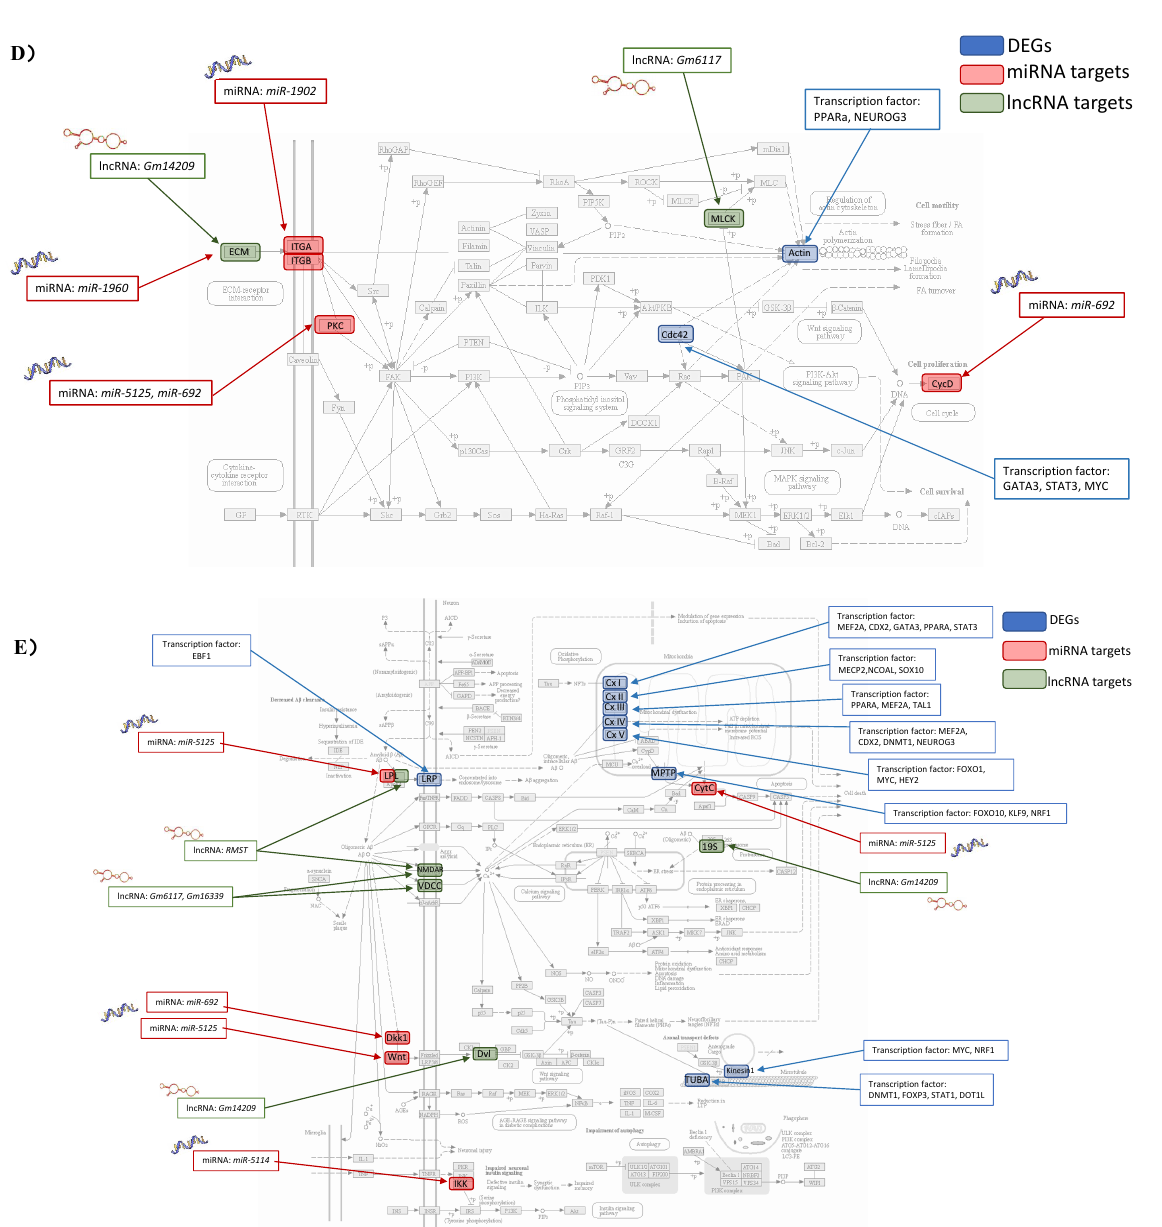
Figure 4. Effect of the high glycemic diet (HGD) on cellular pathways of differentially expressed protein-coding genes, miRNA targets, and LncRNA targets in the hippocampal microvasculature. ( A ) Network of differentially expressed protein-coding genes (grey circles), transcription factors (red hexagons), miRNAs (green diamonds) and their targets (blue circles), LncRNAs (purple rectangles) and their targets (blue circles) in the hippocampal microvessels for the high glycemic diet (HGD) compared to the low glycemic diet (LGD). ( B ) Histogram of a subset of the relevant pathways of differentially expressed protein-coding genes, miRNA targets, and LncRNA targets in the hippocampal microvasculature for the HGD vs LGD. The data are shown for three biological replicates for each dietary group. Statistically significant pathways ( p < 0.05) were identified using Genetrial2 online database and grouped by cellular function. ( C ) Network of important cellular pathways shown in ( B ) and their genes. Pathways are shown in boxes and color coded based on cellular function such as neuro-related (red), cell signaling (green), cell adhesion and mobility (purple), cellular metabolism (yellow), and other cellular pathways (grey). White circles are differentially expressed genes (DEGs) or target genes of miRNAs and lncRNAs. Integrated analysis of ( D ) Focal adhesion and ( E ) Alzheimer’s disease pathways. Blue=DEGs with potential transcription factors (TFs); Red= differentially expressed miRNAs and their targets; Green= differentially expressed lncRNAs and their